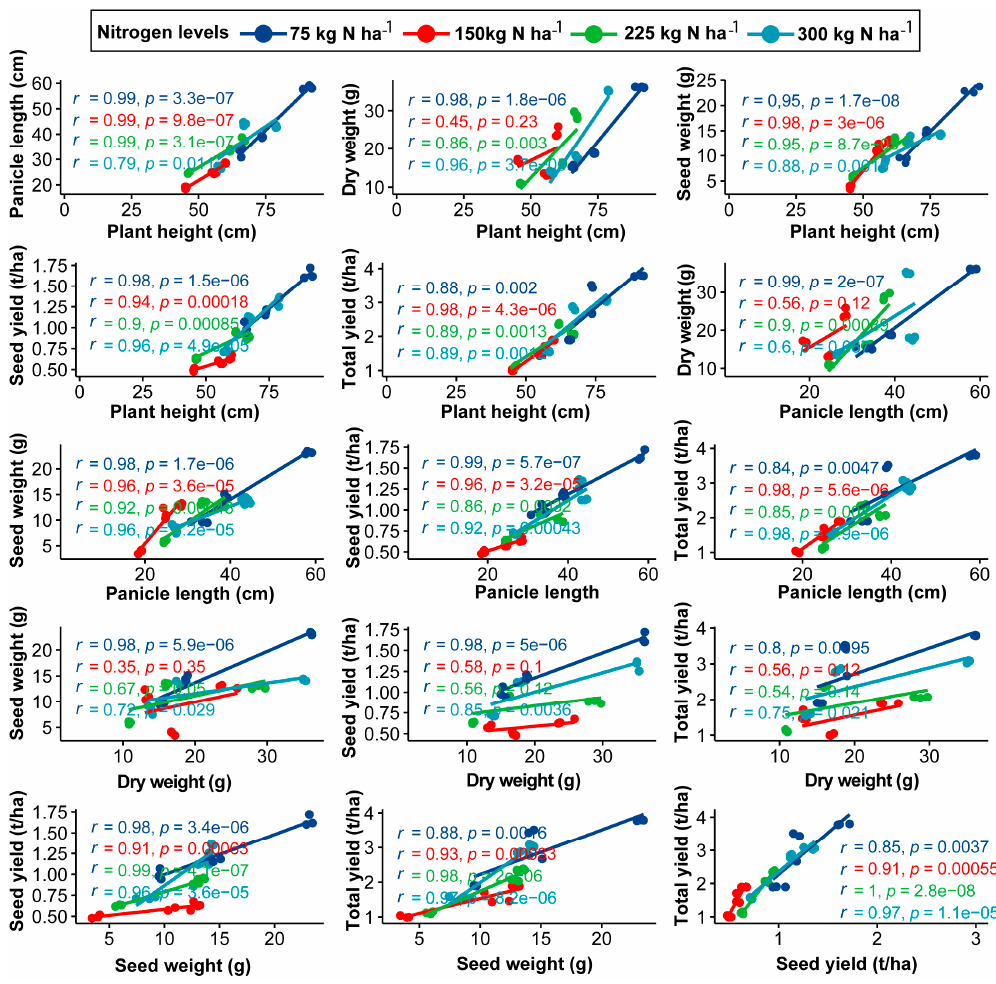
Figure 4. Scatter plot showing the pairwise relationships between six studied quinoa traits under four nitrogen levels (75, 150, 225, and 300 kgN ha − 1 ) averaged over the two seasons of study at Arab El-Awammer Research Station. Correlation coefficients ( r ) and p -values are shown in the upper-left corner of the plot.